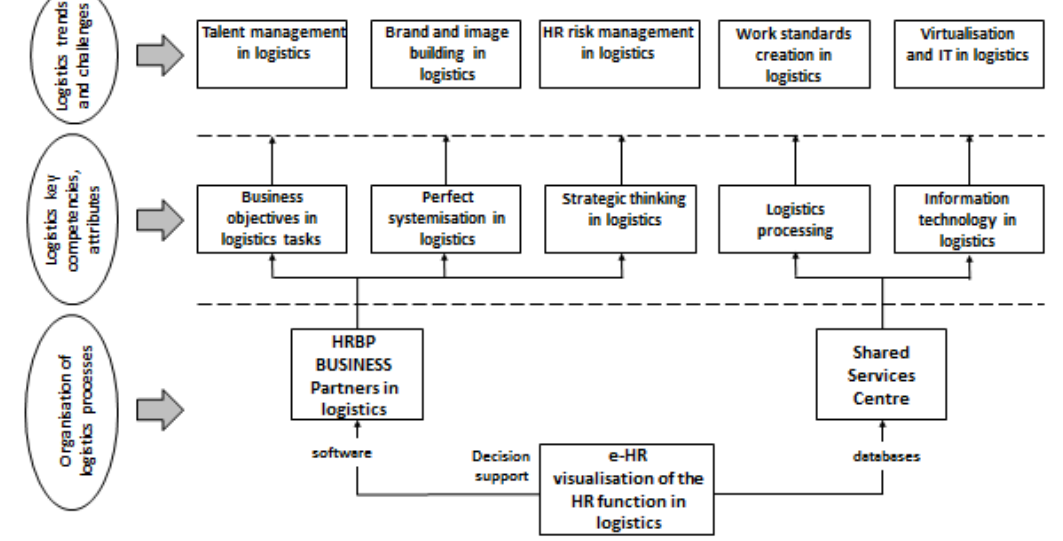
Figure 4. Schematic diagram of the personnel function in logistics management. Source: a uthors’ original original work.